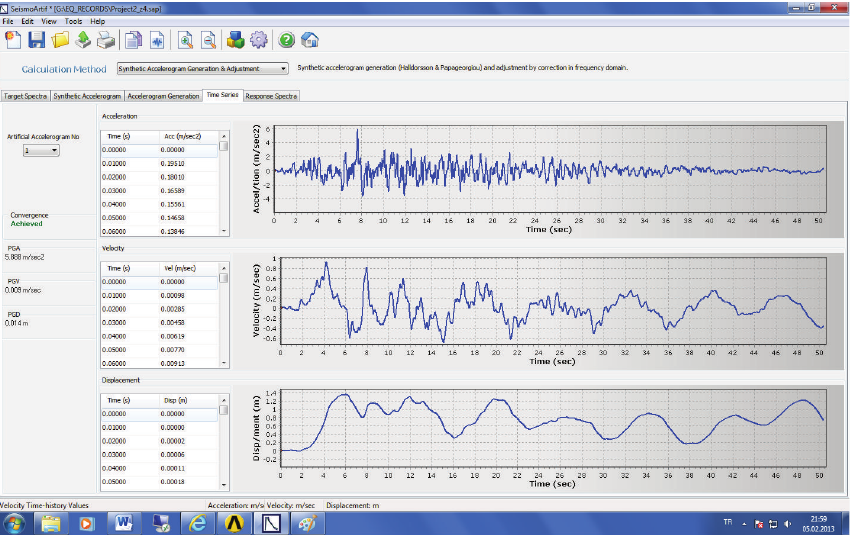
Figure 9: Calculated time series charts for the synthetic accelerogram.